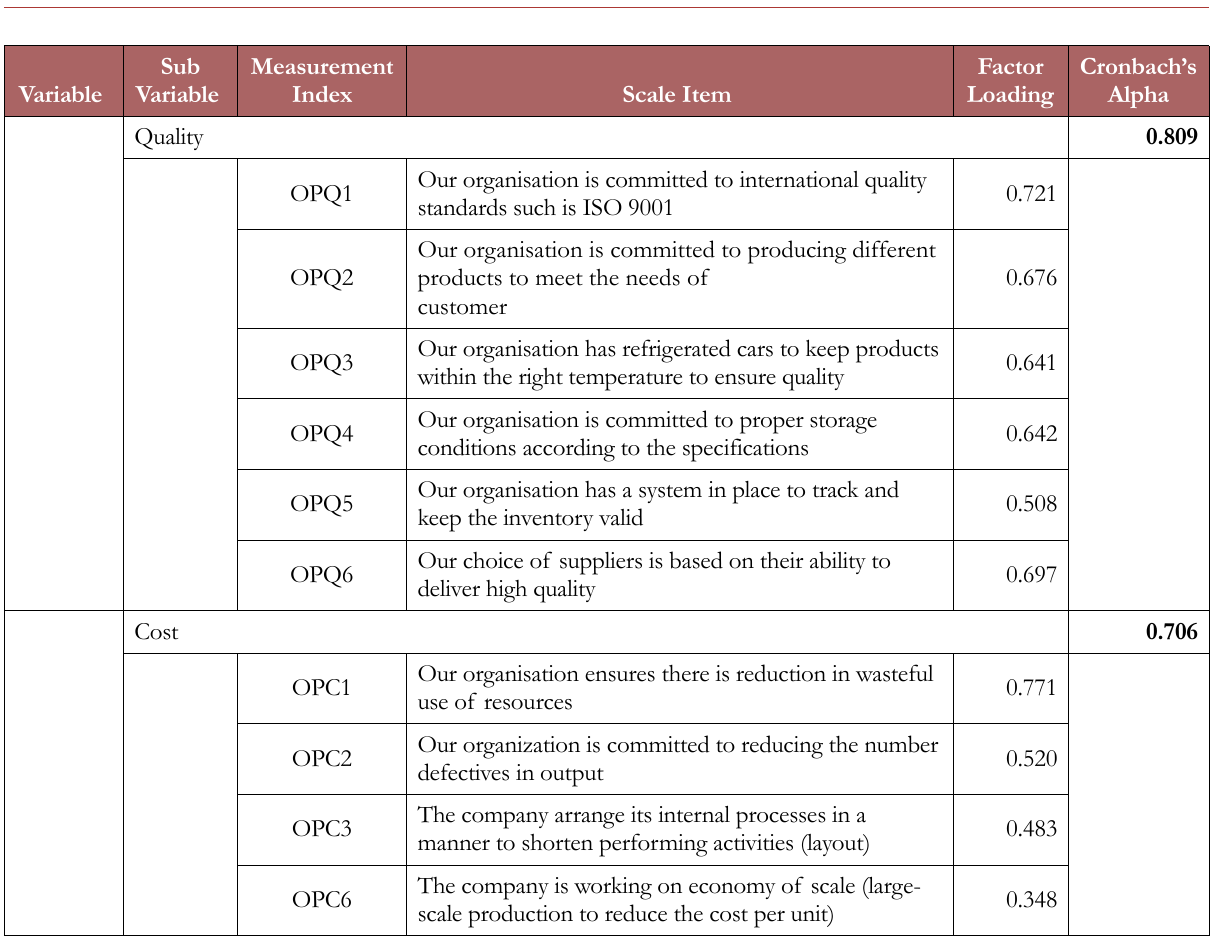
Table 2. Validity and Reliability